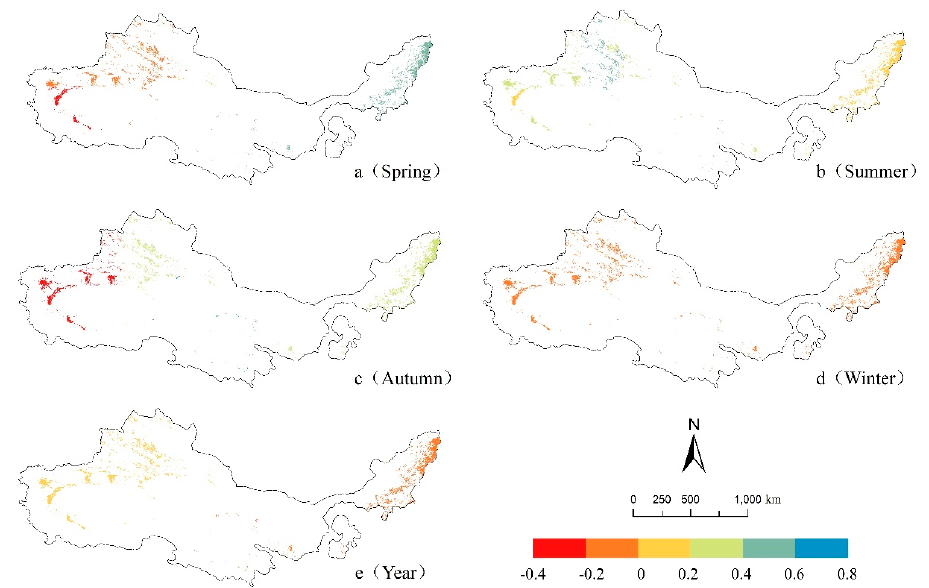
Figure 3. Mean relative soil moisture and the tendency interpolation in arid inland river basin areas during